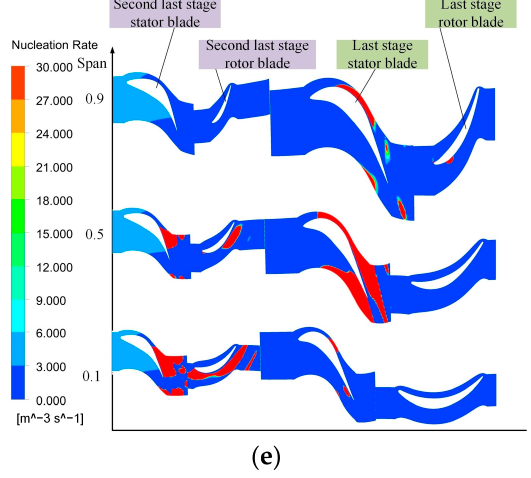
Figure 5. Distribution of nucleation rate along the blade height of steam turbine under different working conditions. ( a – e ), respectively, represent 100%, 50%, 40%, 30%, and 20% THA.